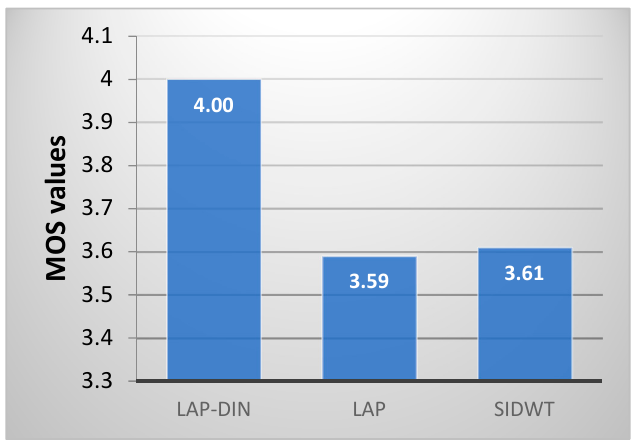
Figure 17. Subjective MOS scores of different fusion methods.